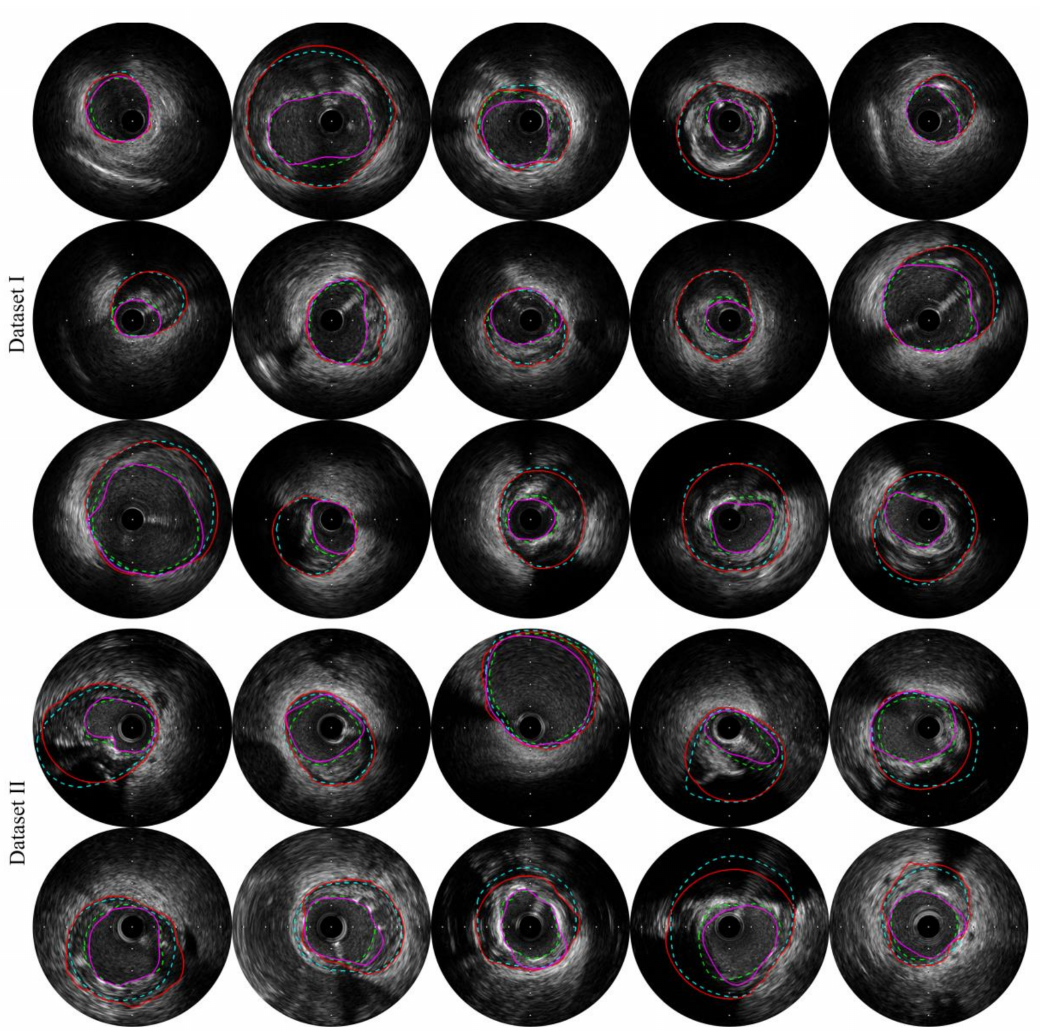
Figure 8. Examples of the segmentation results on Dataset I (the first three rows) and Dataset II (the last two rows). The green dashed line, cyan dashed line, magenta solid line, and red solid line correspond to the manually annotated lumen-intima border (LIB), the manually annotated media-adventitia border (MAB), the auto-detected LIB, and the auto-detected MAB,